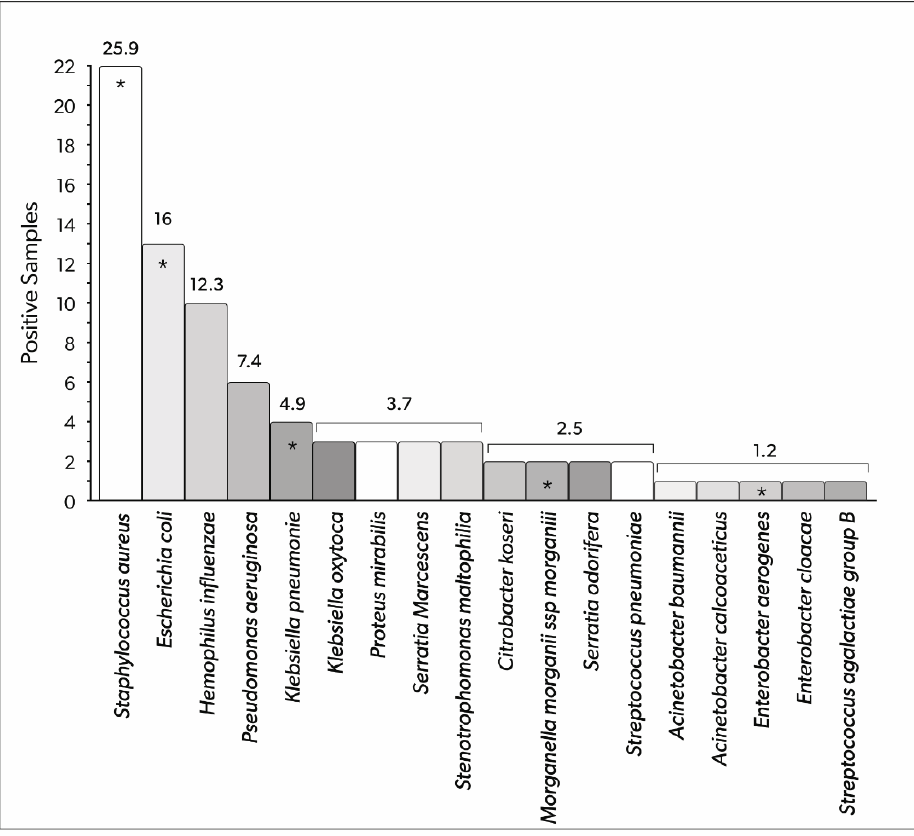
Figure 3. Bacteria detected in the respiratory tract samples of patients with IVAC/PVAP (total number of positive samples). The numbers above the columns represent the relative percentage of the total number of positive samples. Asterisks indicate pathogens that presented multi-drug resistance in at least one sample. IVAC: infection-related ventilator-associated complications; PVAP: possible ventilator-associated